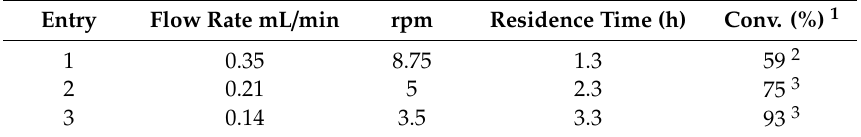
Table 2. Optimization of photochemical transformation of 1a to 2a under